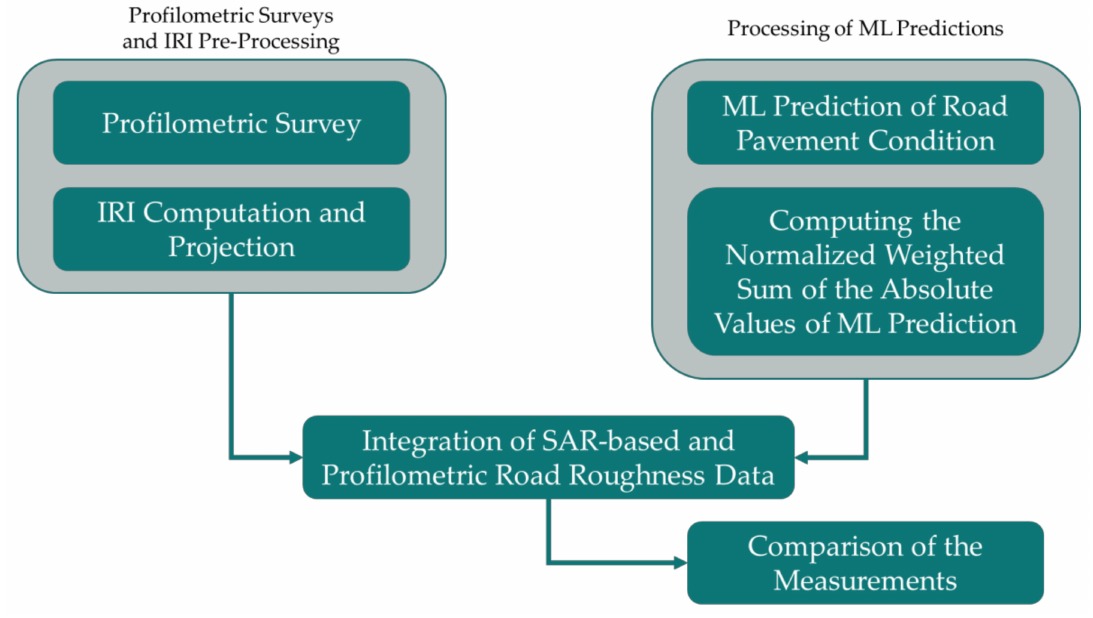
Figure 9. Workflow of the proposed